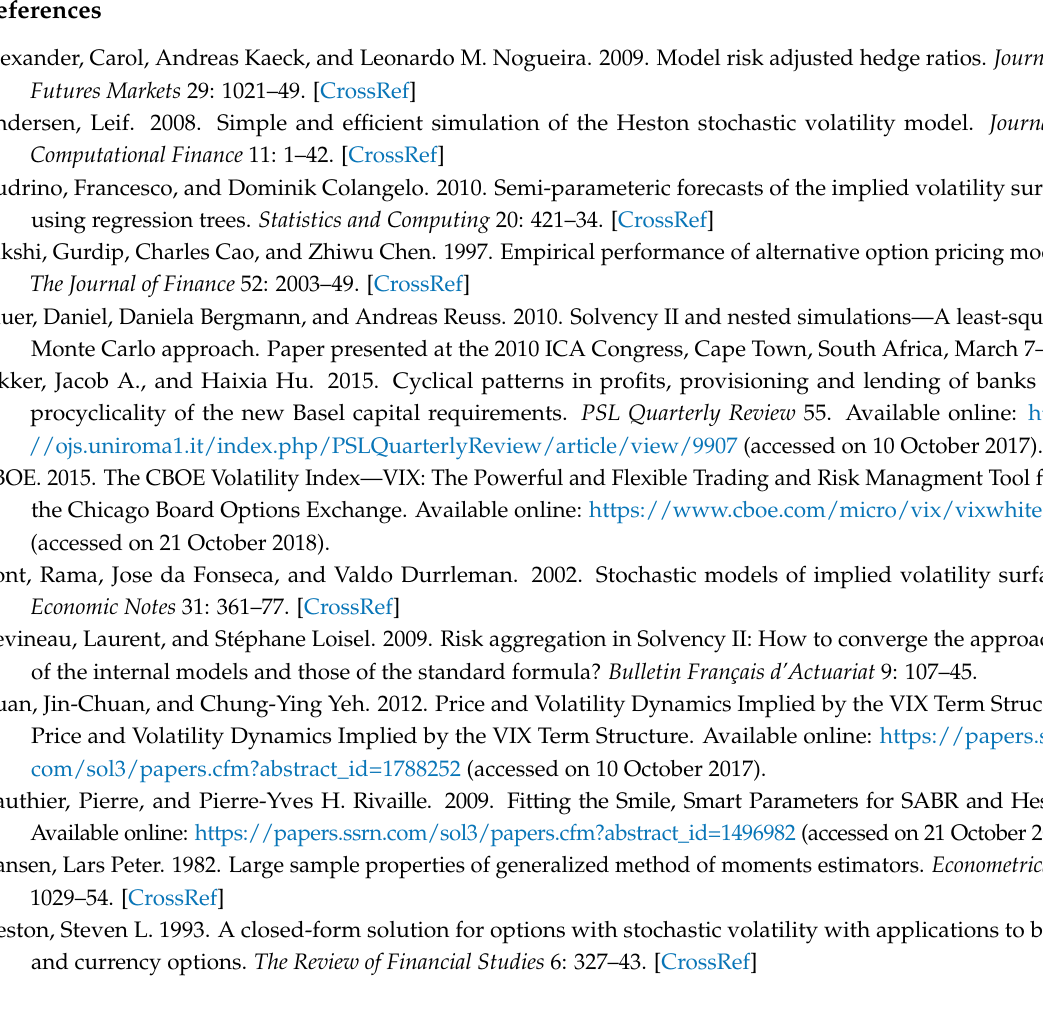
Figure A2. Prediction results Heston parameters of the Europe